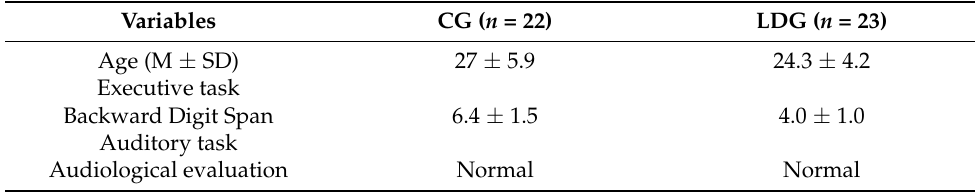
Table 2. Characteristics of the